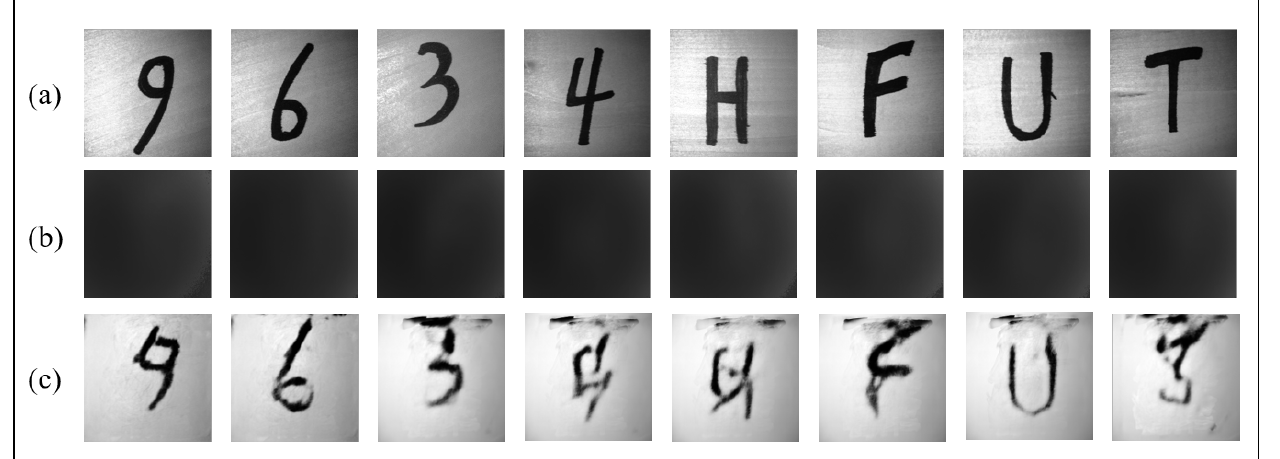
Figure 7. The test results of model-DoP for the untrained target materials. ( a ) Ground truth with target-background as Steel-Paper; ( b ) Scattering DoP images; ( c ) Reconstructed images by the Model-DoP. Table 2. Mueller matrix elements of different materials [19,56].